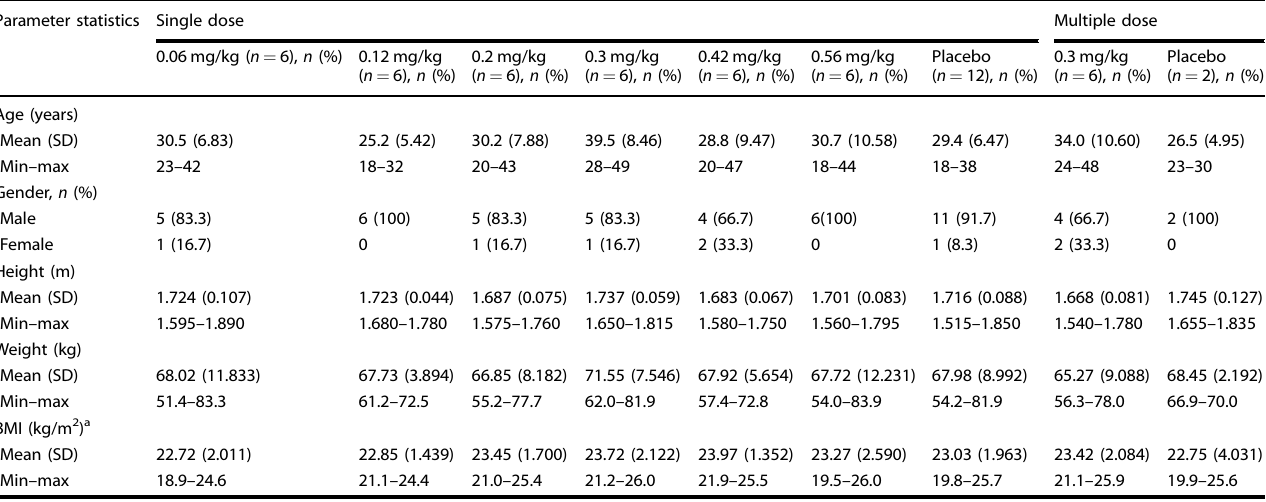
Table 1. Summary of demographics characteristics in phase 1 study Parameter statistics Single